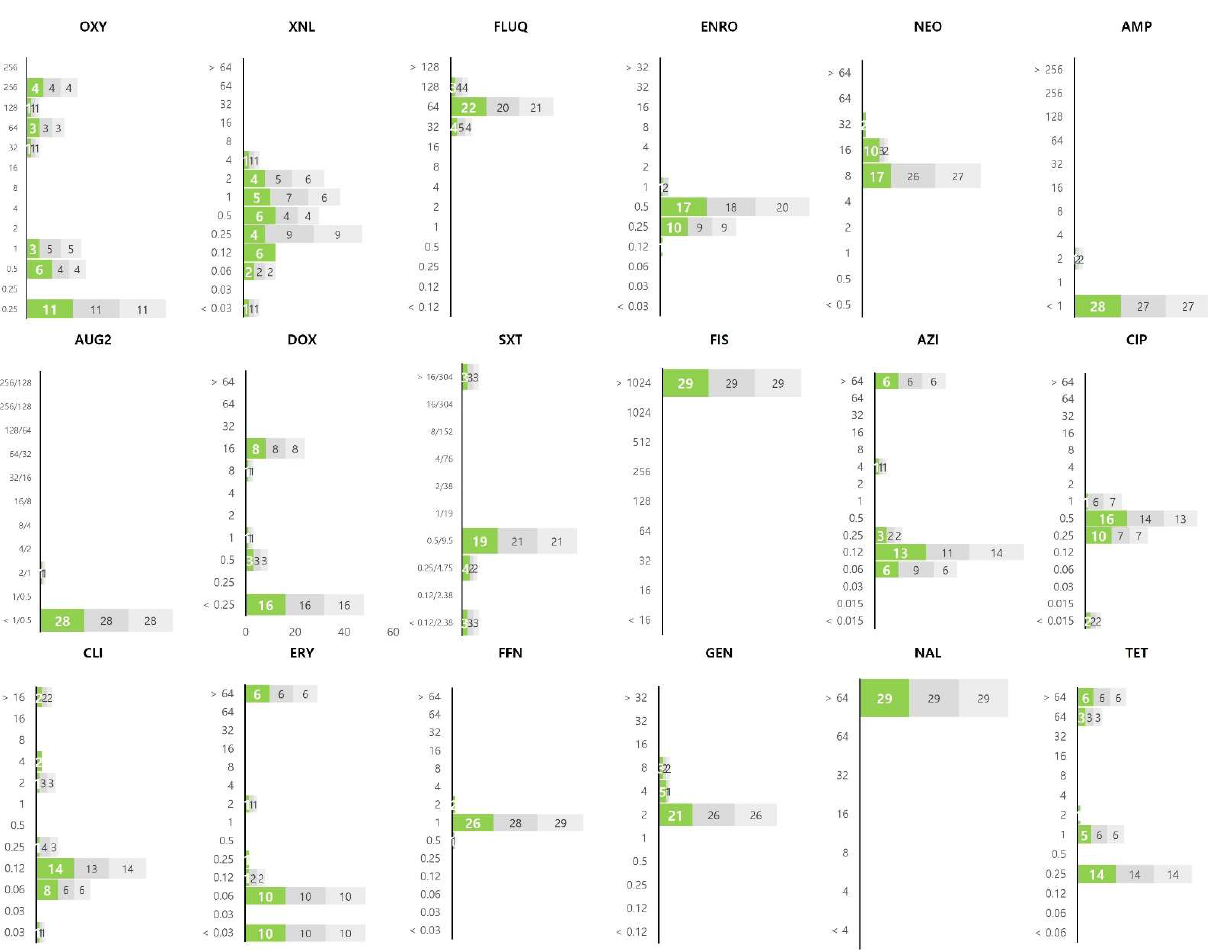
Figure 1. The MIC value distribution of 18 antibiotics against 29 strains of Streptococcus spp. isolated from olive flounders. The X and Y axes of the graph represent the number of isolates and the MIC ( μ g/mL), respectively. The results of the experiment repeated in triplicate are shown in colour on the graph (1st: green, 2nd: dark gray, 3rd: light gray). Oxytetracycline: OXY; ceftiofur: XNL; flumequine: FLUQ; enrofloxacin: ENRO; neomycin: NEO; ampicillin: AMP; amoxicillin/clavulanic acid: AUG2; doxycycline: DOX; trimethoprim/sulfamethoxazole: SXT; sulfisoxazole: FIS; azithromycin: AZI; ciprofloxacin: CIP; clindamycin: CLI; erythromycin: ERY; florfenicol: FFN; gentamicin: GEN; nalidixic acid: NAL; tetracycline: TET.